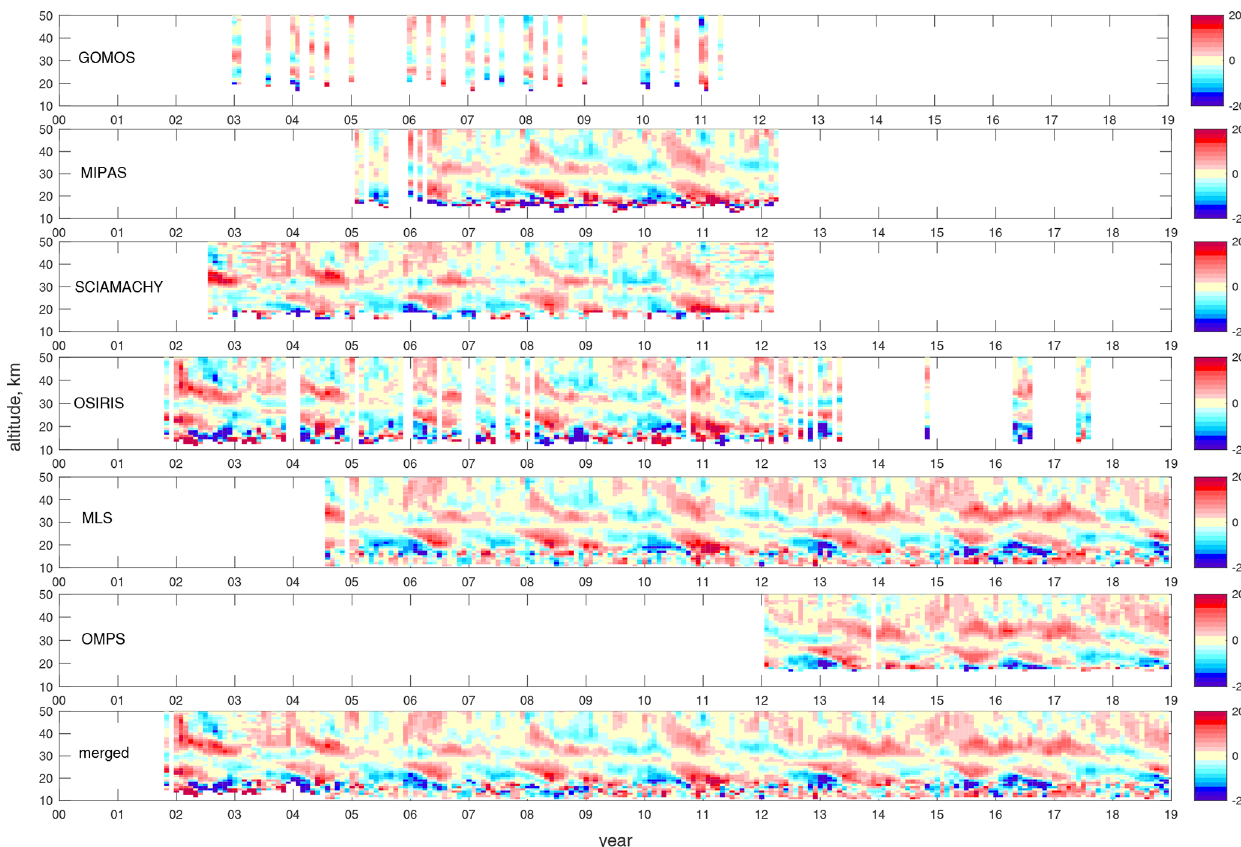
Figure 6. An example of deseasonalized anomalies (in %) for individual instruments and the merged dataset in the spatial bin 0–10 ◦ N, 0–20 ◦